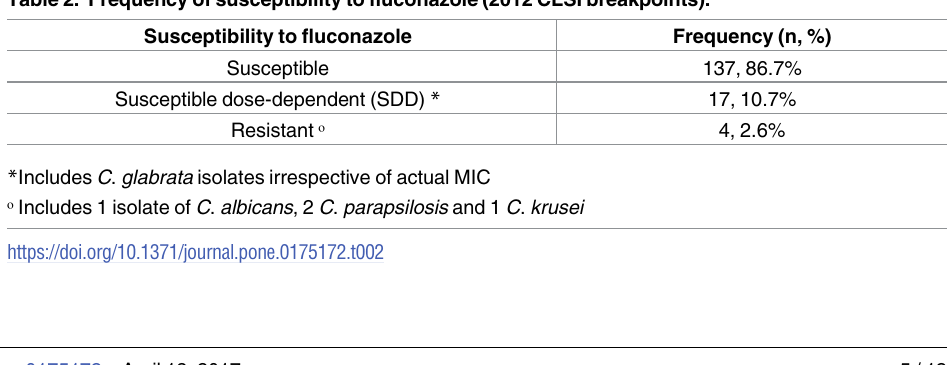
the remaining 13 misidentified isolates.